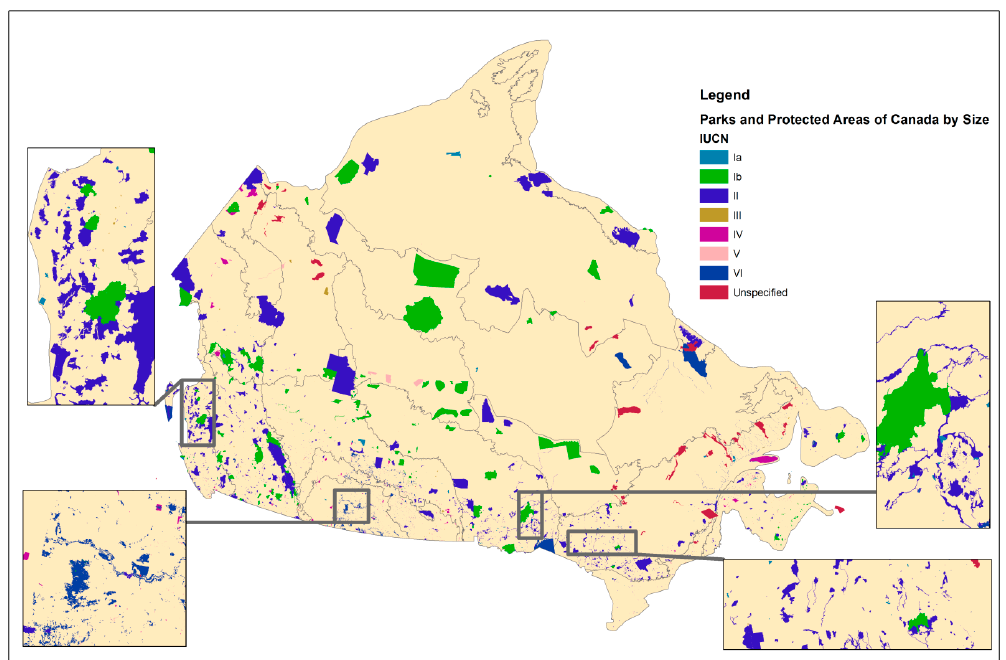
Figure 1. Map of Canadian protected areas and ecozones. Zoom views are provided of select areas to illustrate the context of smaller PAs. IUCN management categories are described in Table 3. Ecozones as described in [18] and labeled in Figure 2.